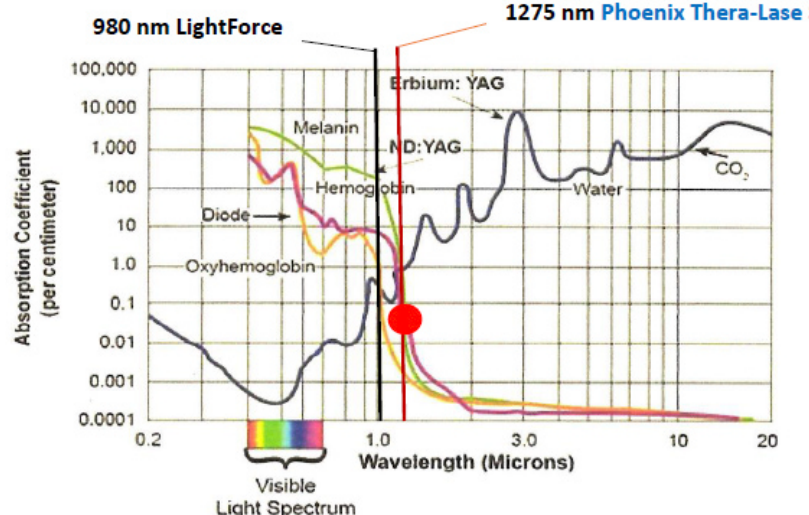
Figure 1. The absorption effect of different wavelengths of infrared light by water, hemoglobin, oxyhemoglobin, and melanin. This figure illustrates one of the effects of the wavelength differences between the Phoenix Thera-Lase and other commercially available high-intensity laser therapy devices (for example, LightForce/LiteCure, erbium-doped yttrium aluminium garnet laser [Er:YAG], and neodymium-doped YAG [Nd:YAG]) with respect to infrared light absorption. These spectra are available from online